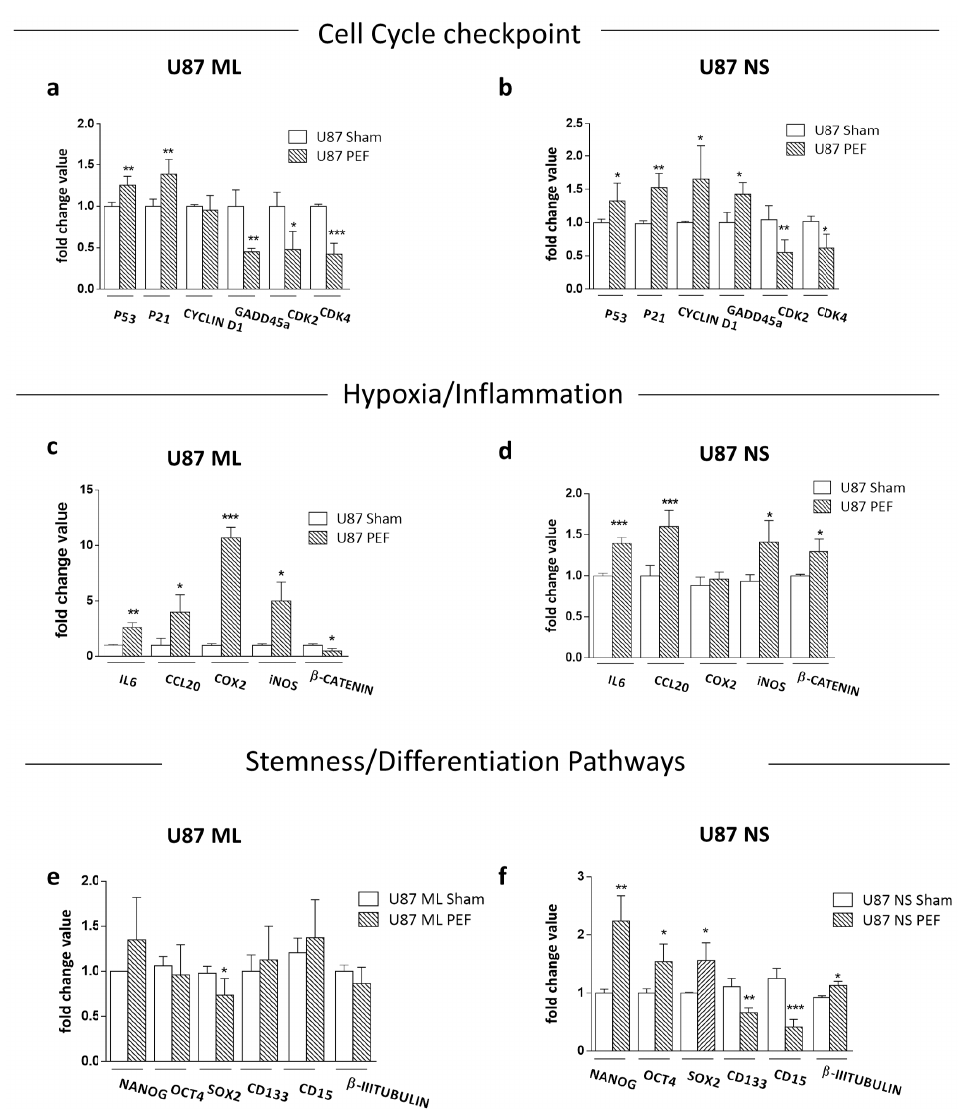
Figure 4. Cell cycle checkpoint, hypoxia/inflammation and stemness/differentiation markers. ( a , b ) Relative mRNA expression levels of genes associated with cell cycle, i.e., P53 , P21 , CYCLIN D1 , GADD45 , CDK2 and CDK4 . ( c , d ) Relative mRNA expression levels of genes associated with hypoxia/inflammation processes, i.e., IL6 , CCL20 , COX2 , iNOS and β -CATENIN . ( e , f ) Relative mRNA expression levels of genes associated with stemness/differentiation processes, i.e., NANOG , OCT4 , SOX2 , CD133 , CD15 and β -III TUBULIN . p values were determined using a two-tailed t test. * p < 0.05; ** p < 0.01; *** p <